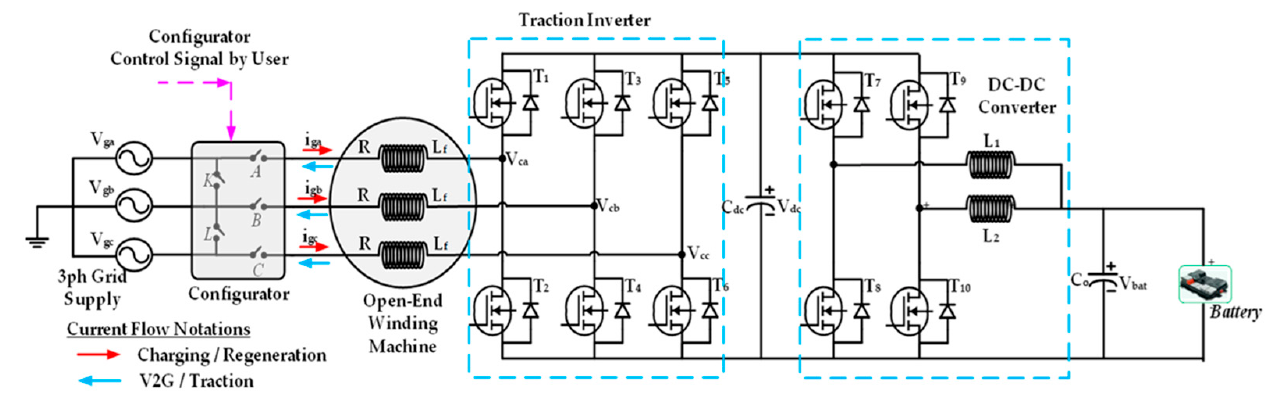
Figure 13. Integrated On − Board Charger based on Open-End Winding Machine proposed by Brull et al. [76] in 2016 (iOBC9).